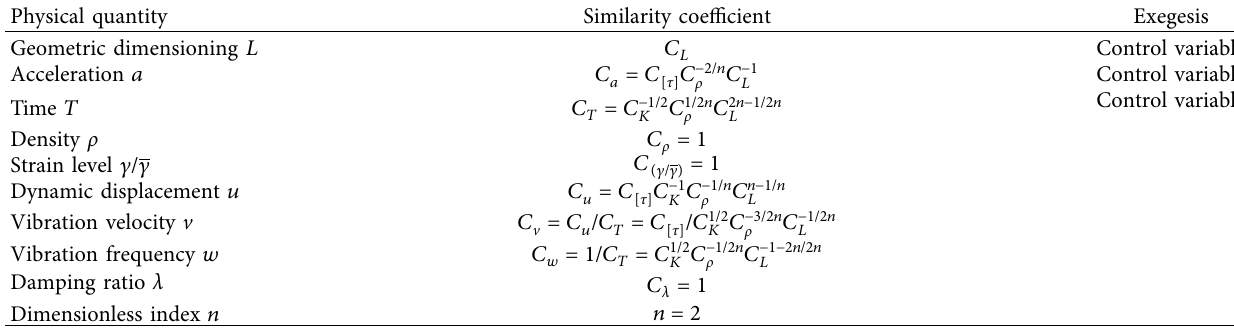
Table 9: Similarity coefficient between our test model and the actual projects.